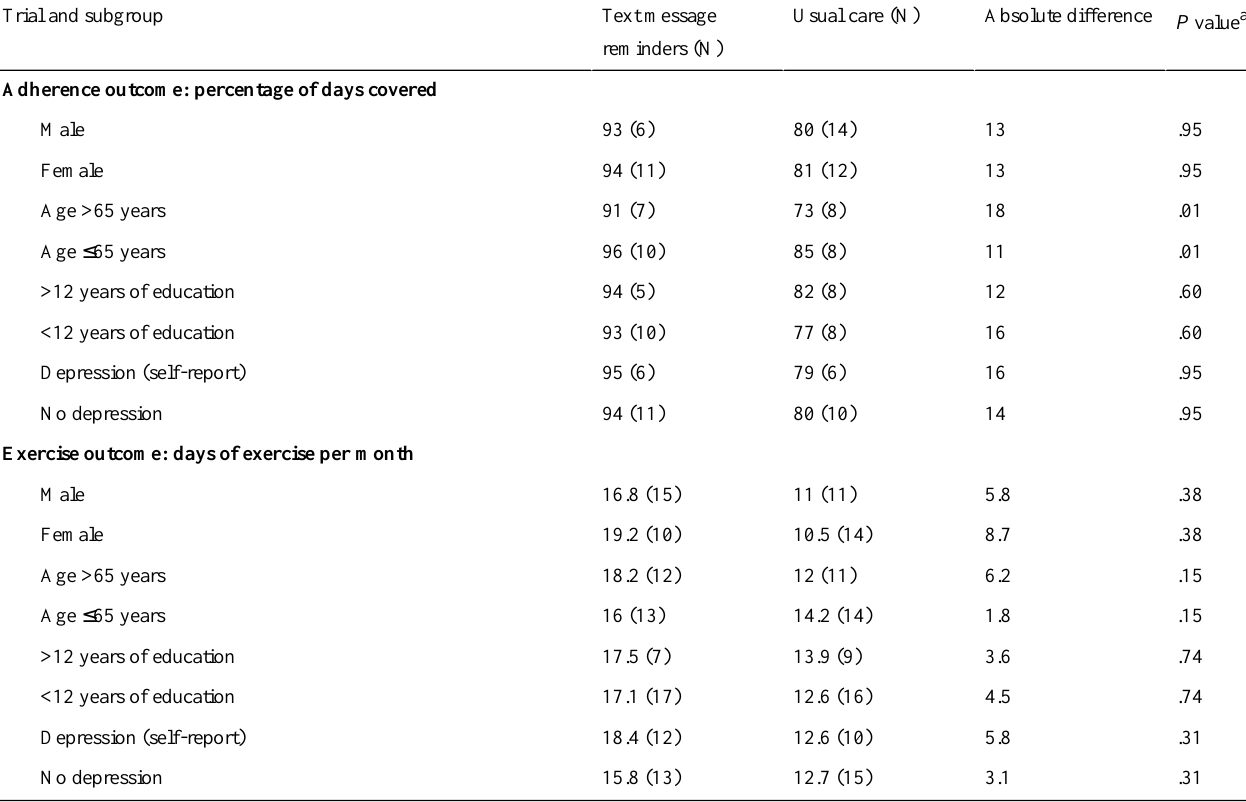
Table 3. Subgroup analysis.